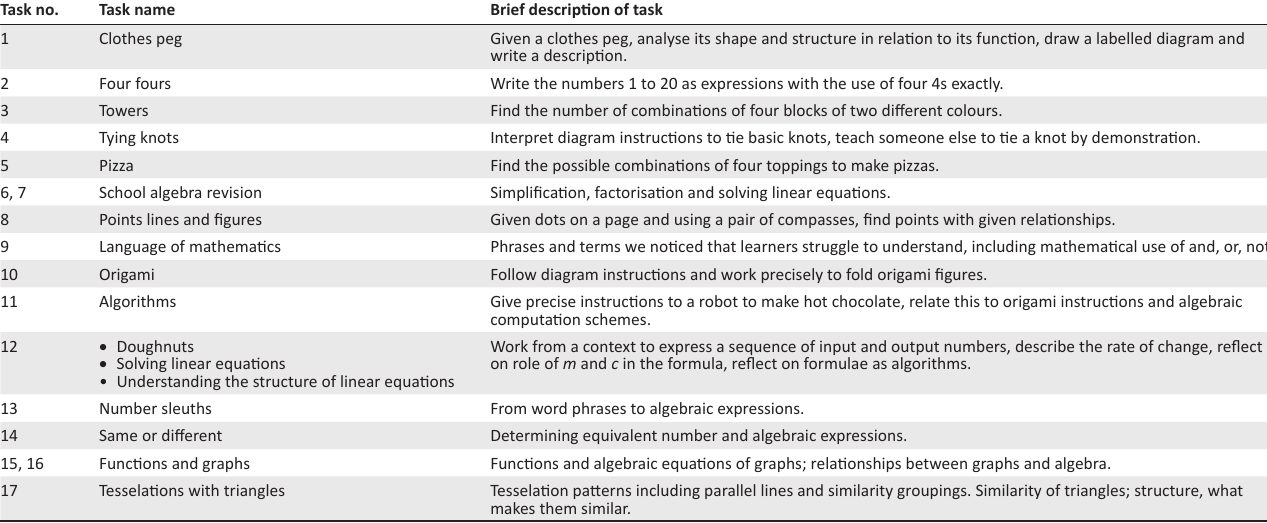
TABLE 1-A1: Task list and